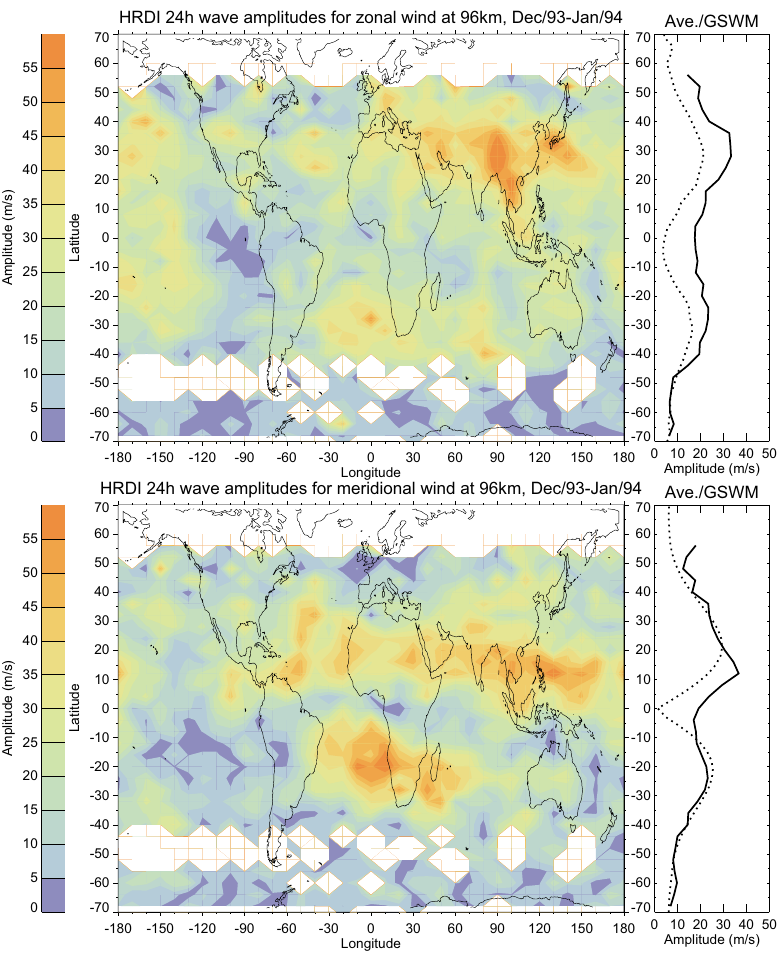
Fig. 3. Contoured plots of 24-h tidal amplitudes for December 1993– January 1994 from HRDI. The longi- tudinal averages are to the right (solid line), and also the GSWM-2000 values